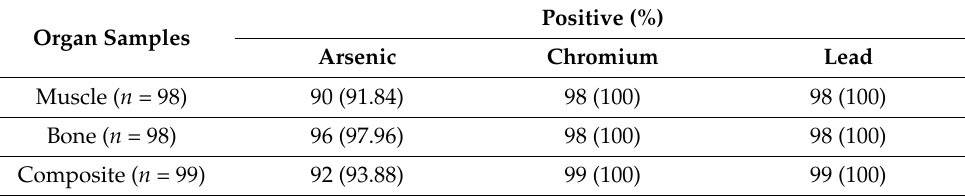
Table 2. Overall percentages of different heavy metals residue in different parts of the broiler body.